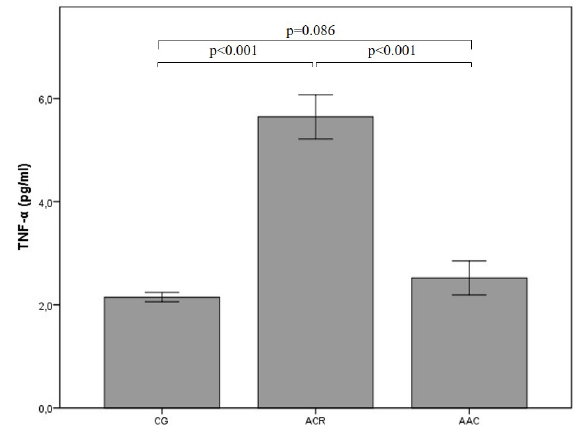
FIGURE 6 - Graphic representation of the threshold pain values (in grams) of the experimental groups according to the examination time. CG control group, ACR acrylamide- treated group, AAC anakinra + acrylamide-treated